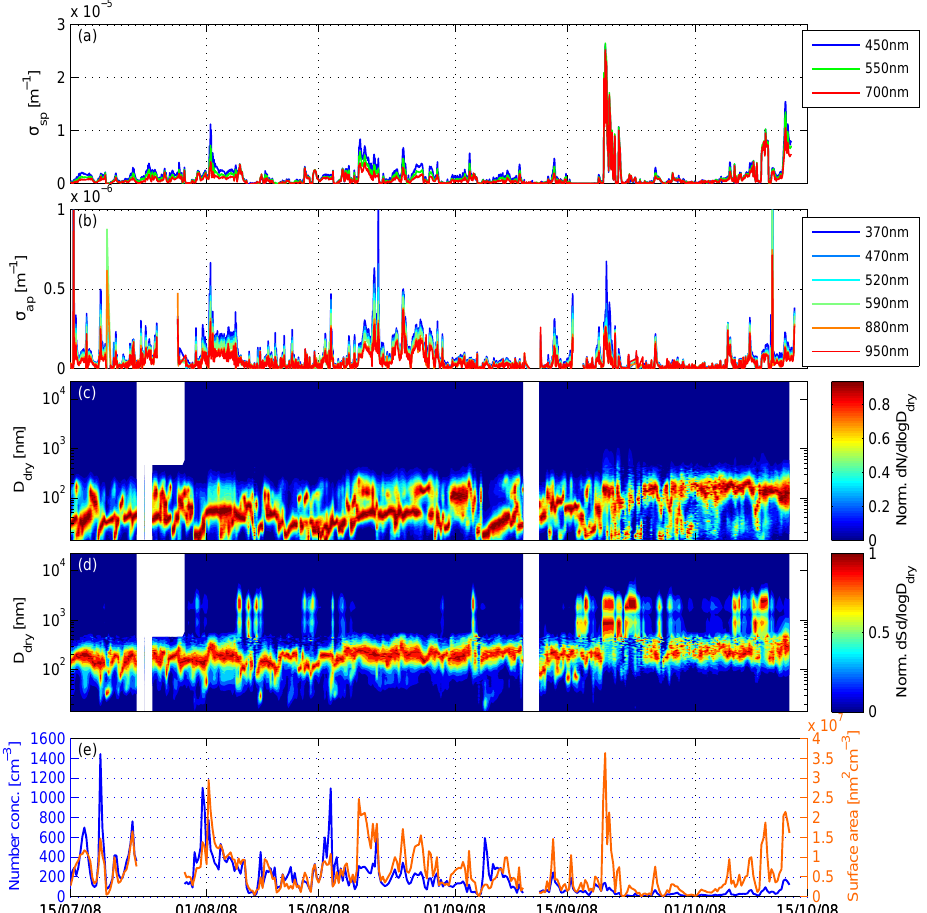
Fig. 3. Overview of recorded data of the entire campaign. (a) : Dry scattering coefficients at 450, 550, and 700nm (DryNeph, hourly averages). (b) : Absorption coefficients at different wavelengths (aethalometer, hourly averages, without 660nm). (c) : Normalized number size distribution (SMPS and OPC, 6h averages). (d) : Normalized surface size distribution measured (SMPS and OPC, 6h averages). (e) : Total number concentration (blue line) and total surface area (orange line) measured by SMPS and OPC (6-h averages).